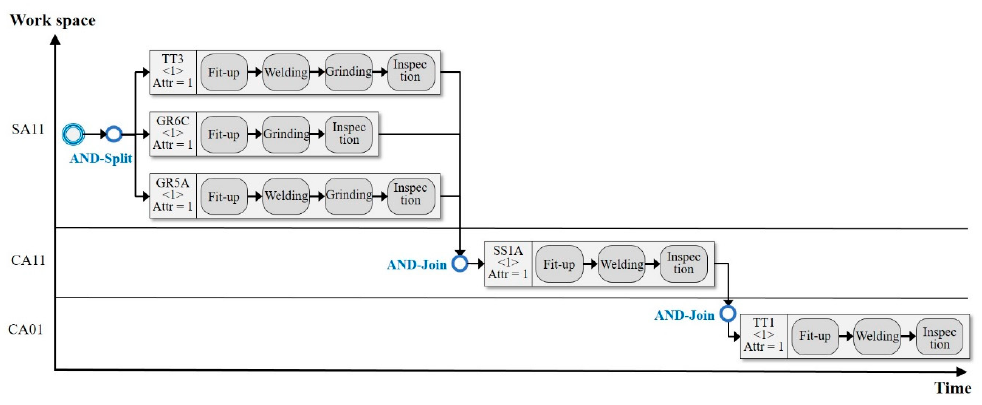
Figure 10. Process-based model for describing a large assembly factory.